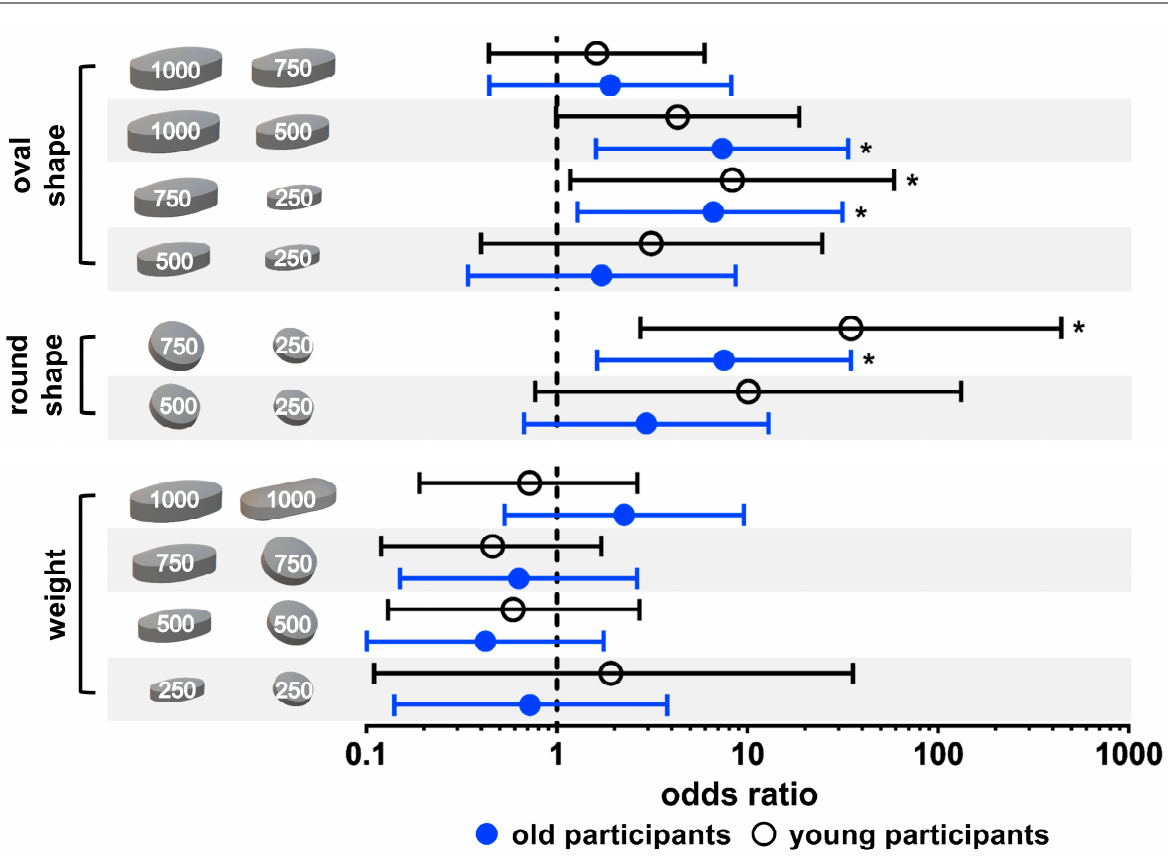
Figure 4. Statistical analysis of tablet ratings categorized as well swallowable vs. not/moderately swallowable using the Fisher’s exact test and applying Benjamini Hochberg correction. Results for old participants are shown in blue, while those for young participants are shown in black. Dots and circles are representing odds ratios and bars are marking the upper and lower con fi dence interval boundaries (98.5% con fi dence interval for old participants and 98.0% con fi dence interval for young participants). Asterisks indicate signi fi cant di ff erence.